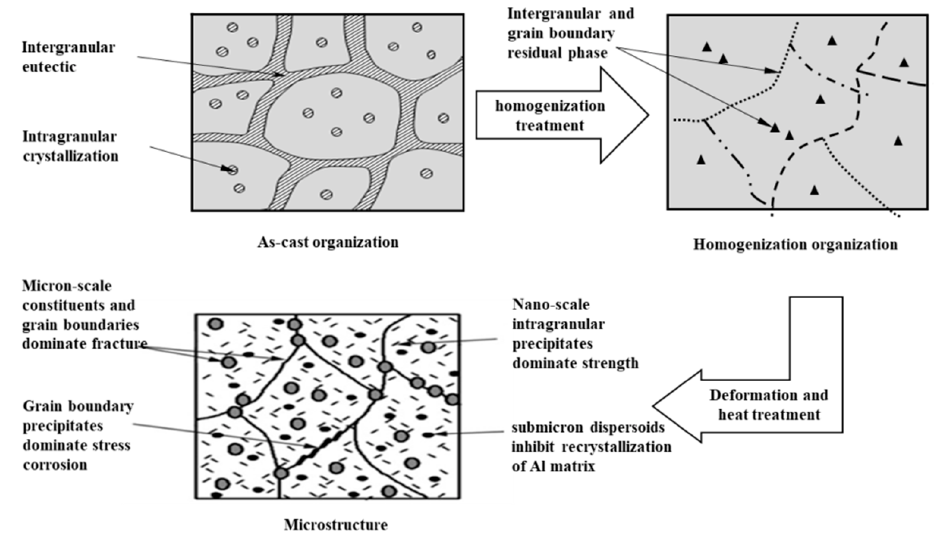
Figure 8. Microstructure evolution of Al 7XXX alloys [97,98].